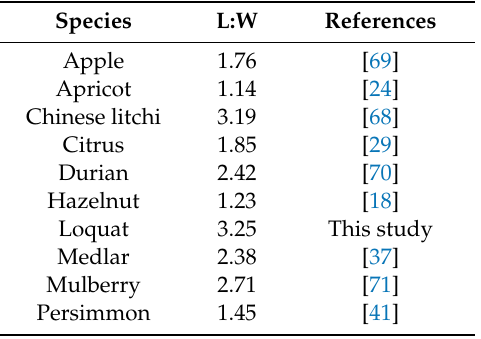
Table 3. Comparison of mean values of leaf shape ratio of Loquat with other values reported for other fruit crops in the